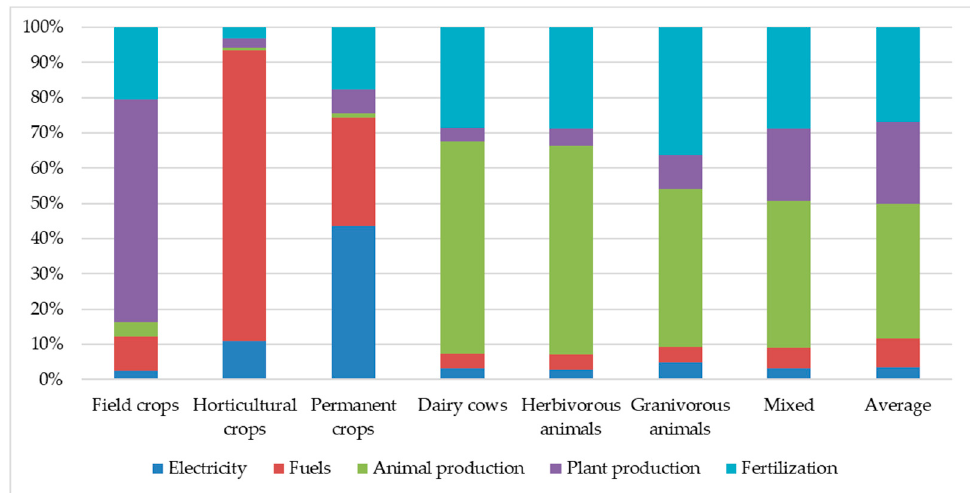
Figure 7. Structure of GHG emissions in types of farms. Source: own study.